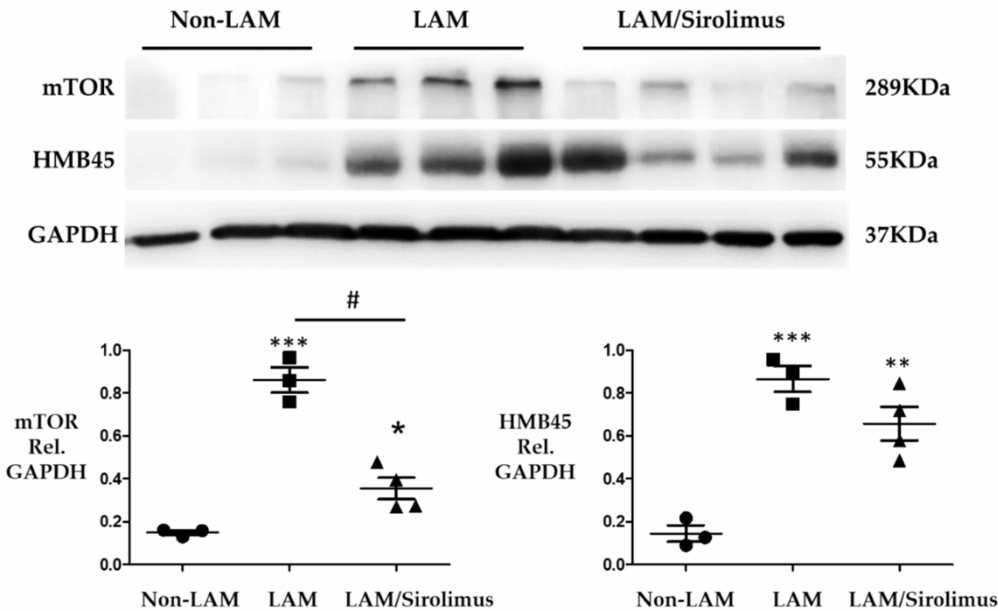
Figure 2. Effect of sirolimus on decreasing mTOR expression. Representative quantifications of the immunoblot den- sitometries of protein expression are shown for lungs from the two groups. mTOR (289-kDa band) expression was increased in the lung tissues of LAM patients, and this change was reversed by administering sirolimus (LAM/sirolimus). HMB45 (55-kDa band) expression was increased in the lung tissues of LAM patients but did not decrease significantly after sirolimus administration (LAM/sirolimus), relative (Rel.). The bars represent the mean ± SEM for n = 3-4 samples. * p < 0.05, ** p < 0.01, *** p < 0.001 compared with the non-LAM group. # p < 0.05 compared with the LAM group without sirolimus